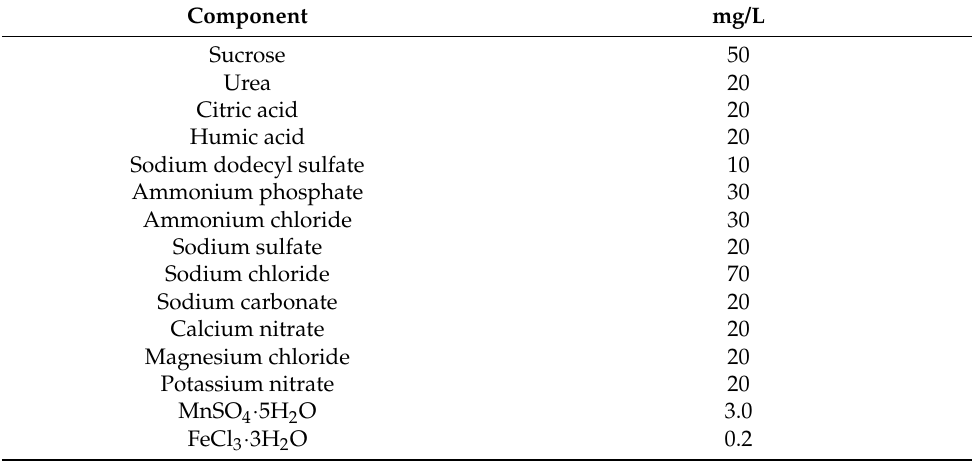
Table 1. Composition of synthetic